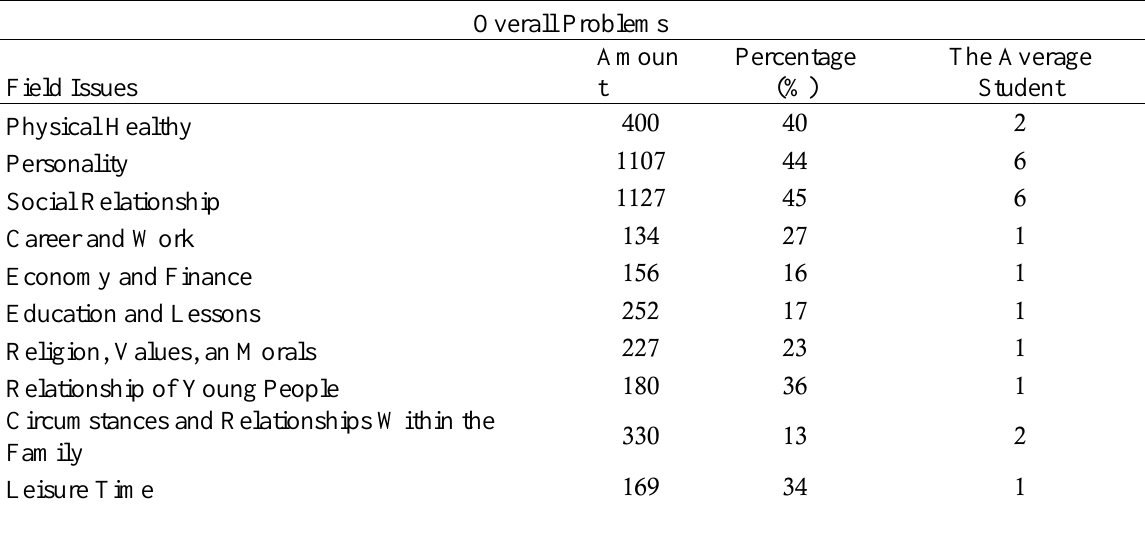
Table 1. Results of data group of junior high school students